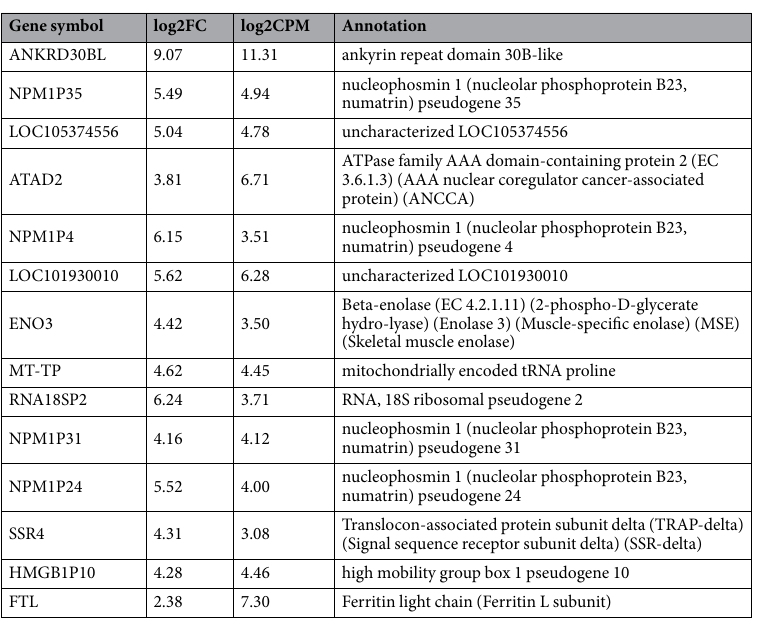
Table 3. Differentially expressed human genes between health and periodontitis in periodontal pockets. Reads were mapped against the human reference genome (ver. GRCh38) to investigate the response of the host. The table lists the differentially expressed host genes calculated by